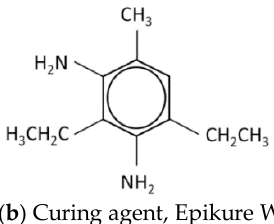
Figure 2. Molecular formulas.